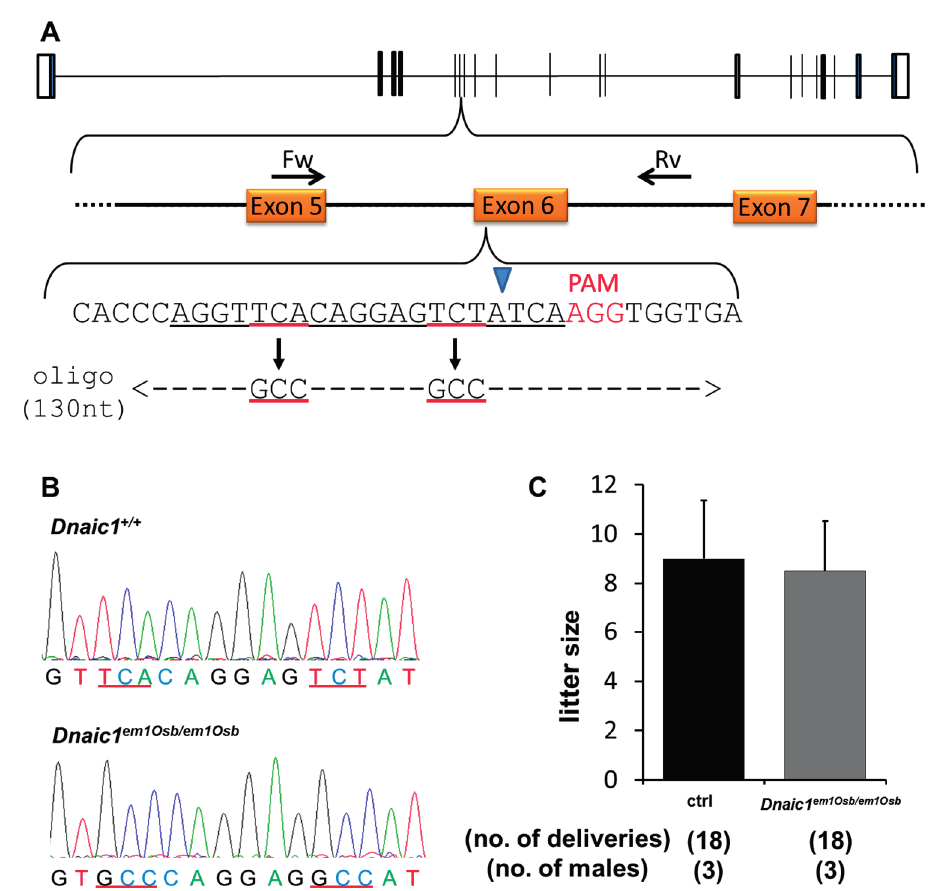
Figure 2. CRISPR/Cas9 strategy and results for Dnaic1 em1Osb/em1Osb male mice. ( A ) Dnaic1 exon 6 was targeted; coding exons shown as solid black bars, non-coding exons shown as open bars. Forward (Fw) and reverse (Rv) primers for validation and genotyping shown; black arrows labelled Fw and Rv. sgRNA sequence; underlined in black. Mutation targets underlined in red. PAM sequence is shown in red. Blue arrowhead indicates site of Cas9 digestion. Single strand oligonucleotide containing desired mutation; underlined in red, dashed line indicates sequence homologous to wild-type Dnaic1 sequence; ( B ) Sequencing of Dnaic1 em1Osb/em1Osb mice; targeted mutation underlined in red; ( C ) Natural mating analysis of Dnaic1 em1Osb/em1Osb male mice with WT